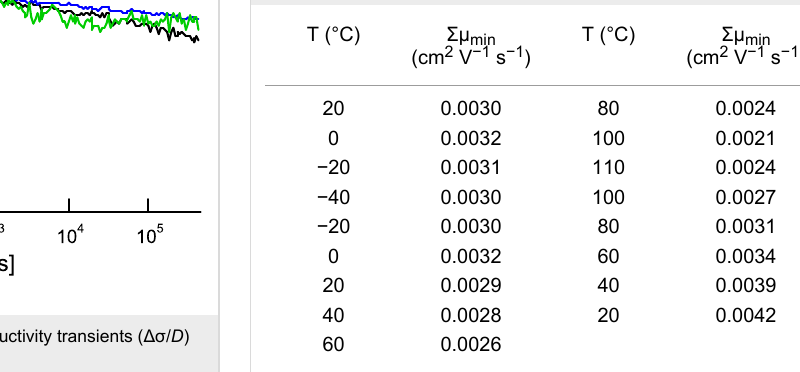
Table 2: Charge carrier mobilities of T1 at various temperatures in the sequence as measured in two experimental